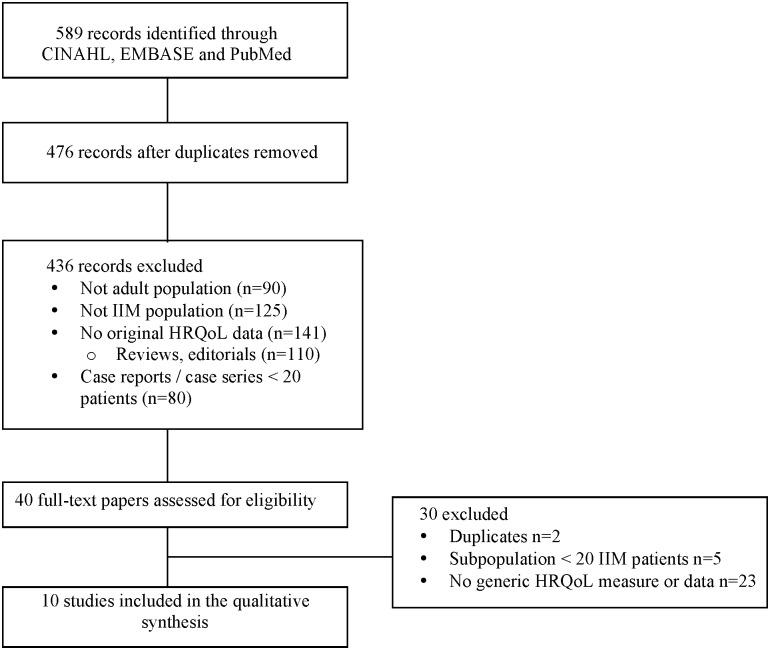
Flow diagram of study selection.